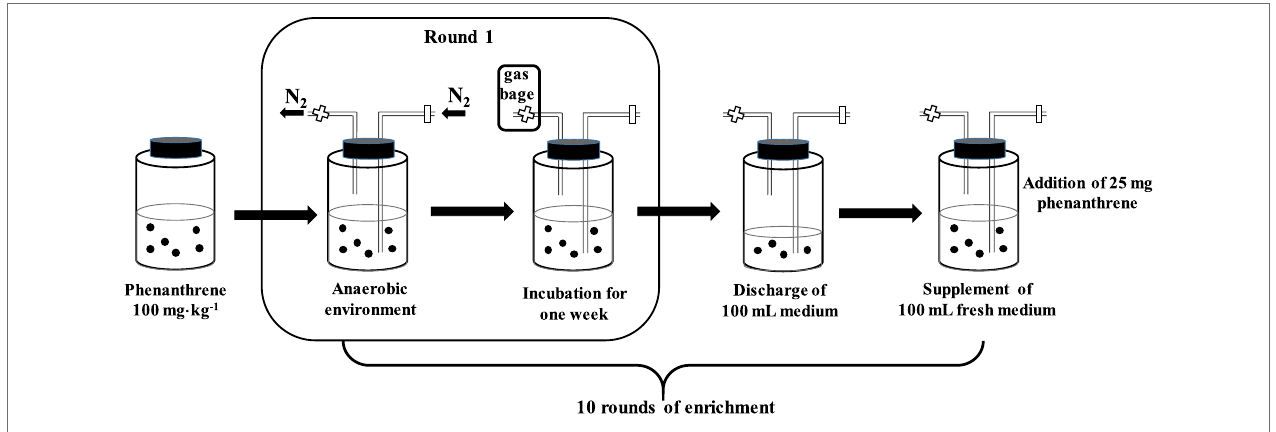
FIGURE 1 | The diagrammatic sketch showing the enrichment procedure of the phenanthrene-degrading consortium under